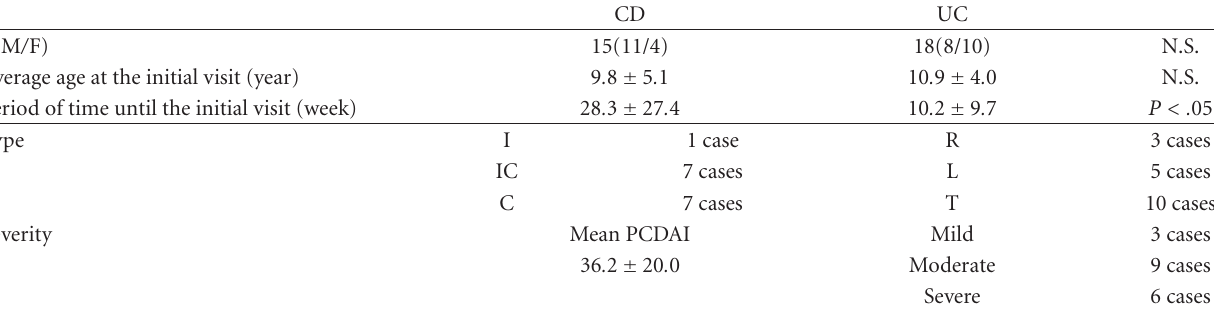
Table 1: Profile of children with CD ( n = 15) and those with UC ( n = 18) (mean ± SD).